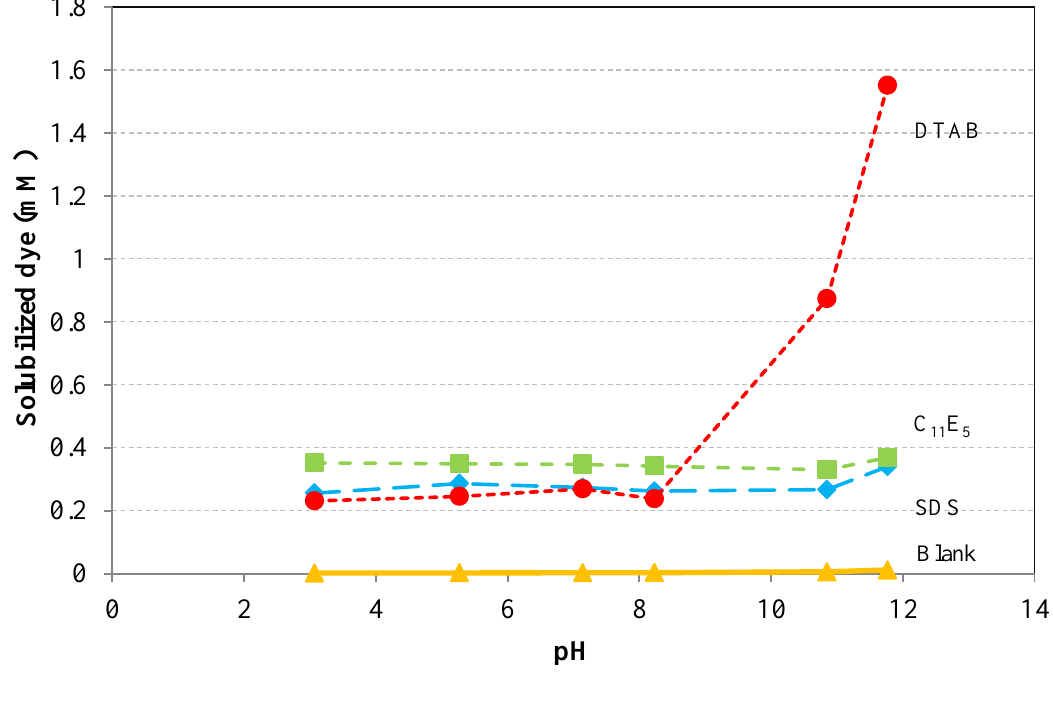
E ), all at a concentration of 10 g/L 11 5